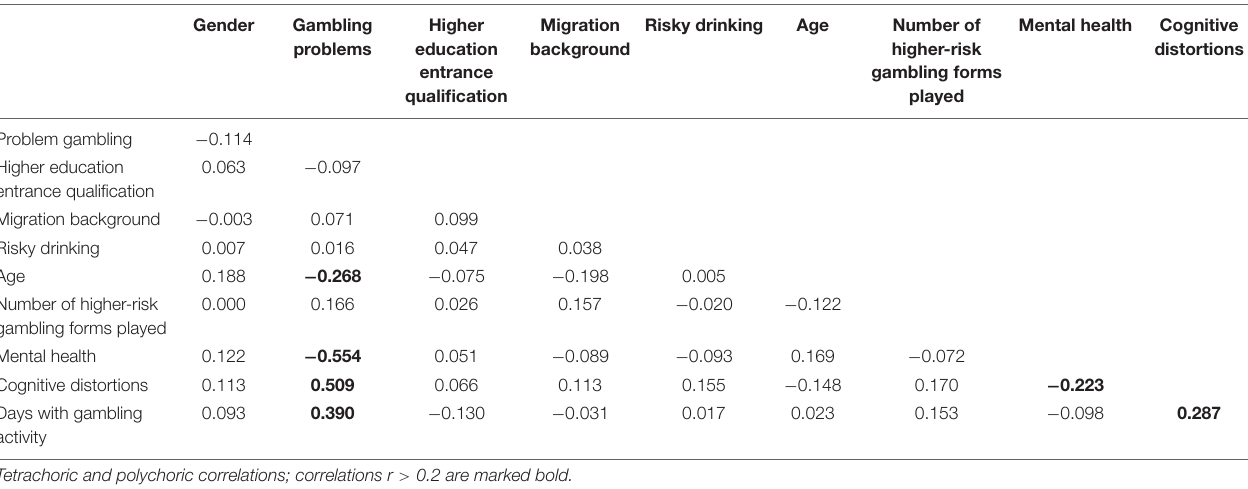
TABLE 4 | Parameters for changes in gambling behavior – comparison of gambling groups (multivariate multinomial logistic regression). Switching to higher-risk online gambling forms ( N =